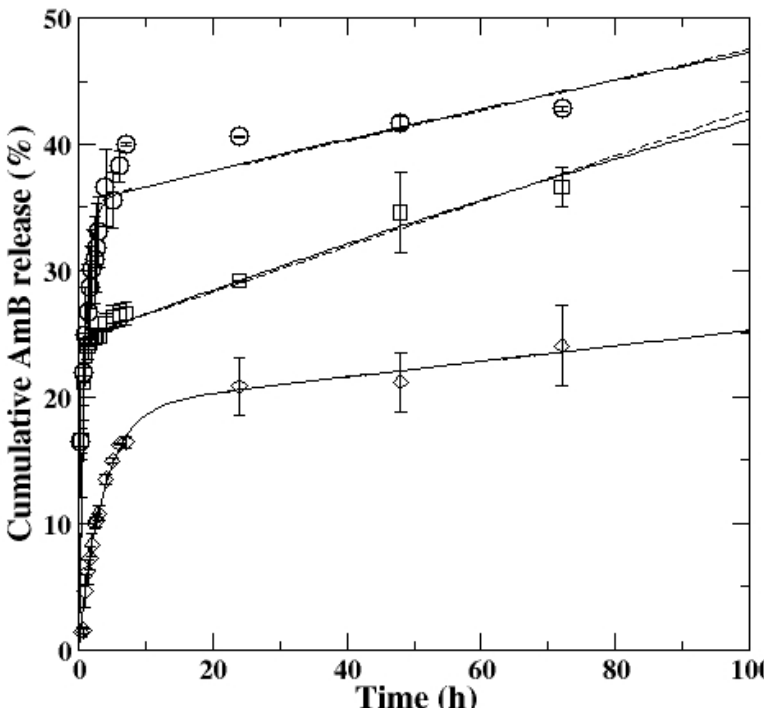
), CGProp AmB ( (cid:3) ), (cid:35)